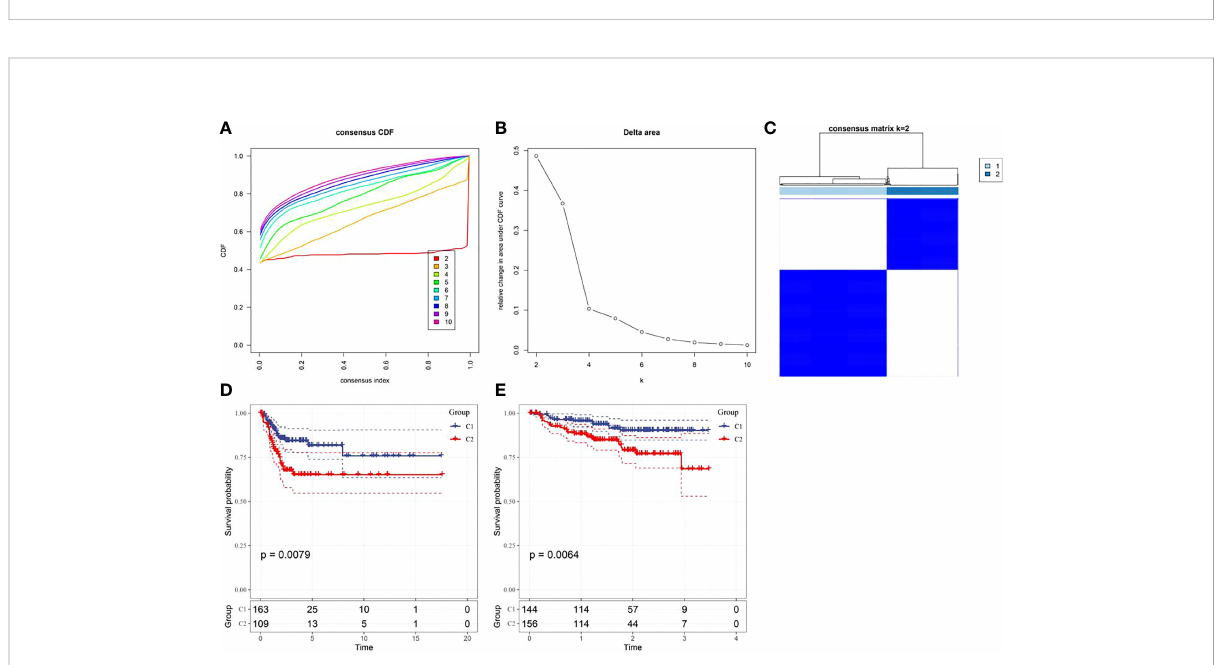
FIGURE 4 Construction of fatty acid metabolism-related subtypes and prognosis (A) Consensus clustering samples between each category number k in the TCGA cohort; (B) Delta area curve of cumulative distribution function (CDF) of TCGA cohort sample; (C) Heat map of sample clustering when k=2; (D) Kaplan-Meier curve of two subtypes in the TCGA cohort; (E) The prognostic Kaplan-Meier curves of the two subtypes in the GSE44001